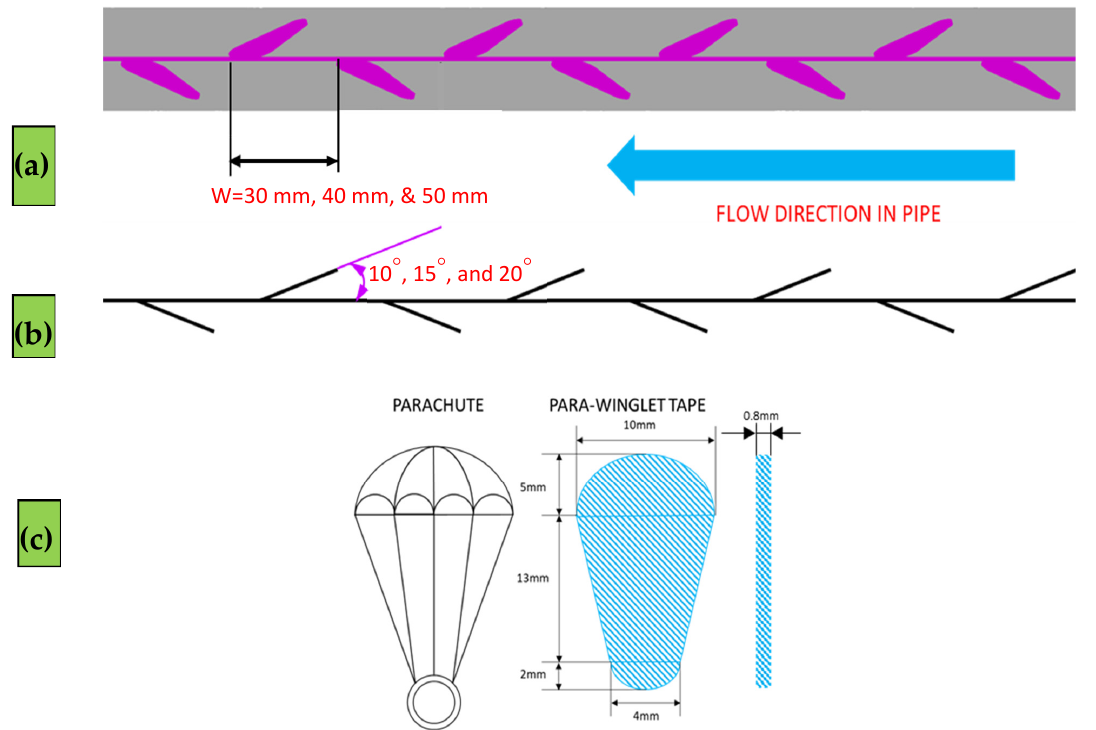
Figure 2. ( a )Positioning of PWT inserts inside tube ( b )Angle Orientation of PWT inserts ( c ) Design Figure 2. ( a ) Positioning of PWT inserts inside tube ( b ) Angle Orientation of PWT inserts ( c ) Design of Single PWT [29]. of Single PWT [29].